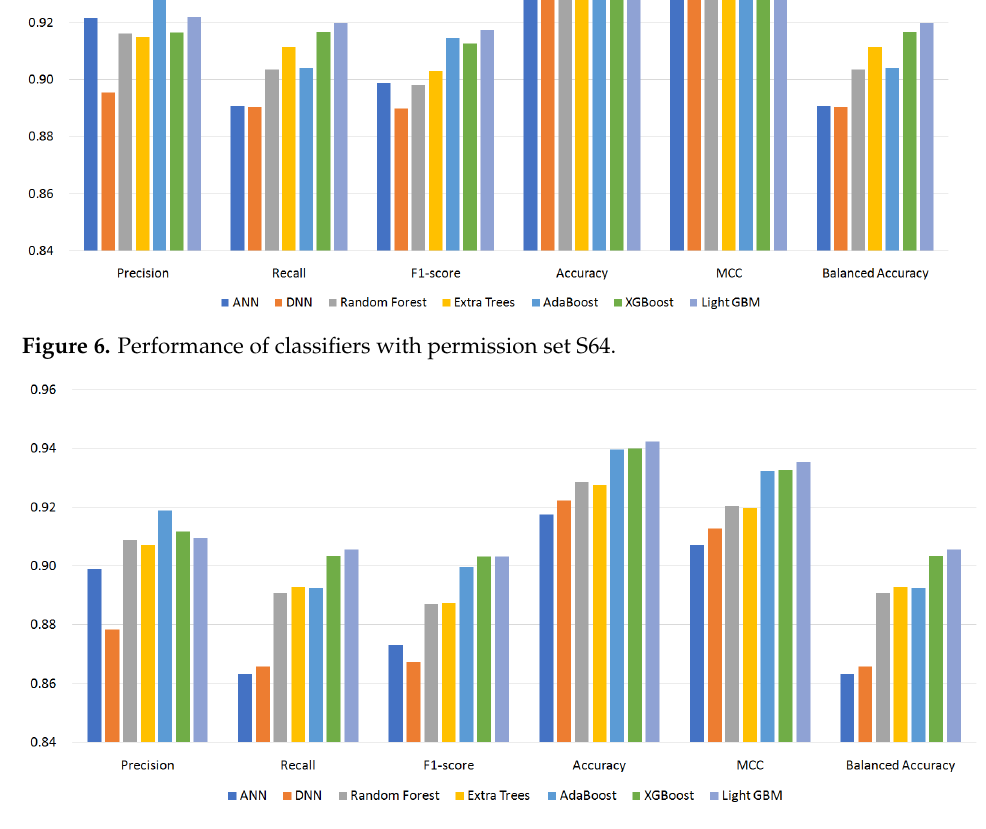
Figure 7. Performance of classifiers with permission set S56. Table 3. Most effective classifiers and measured values. The highest value for each metric is emphasized as bold-face